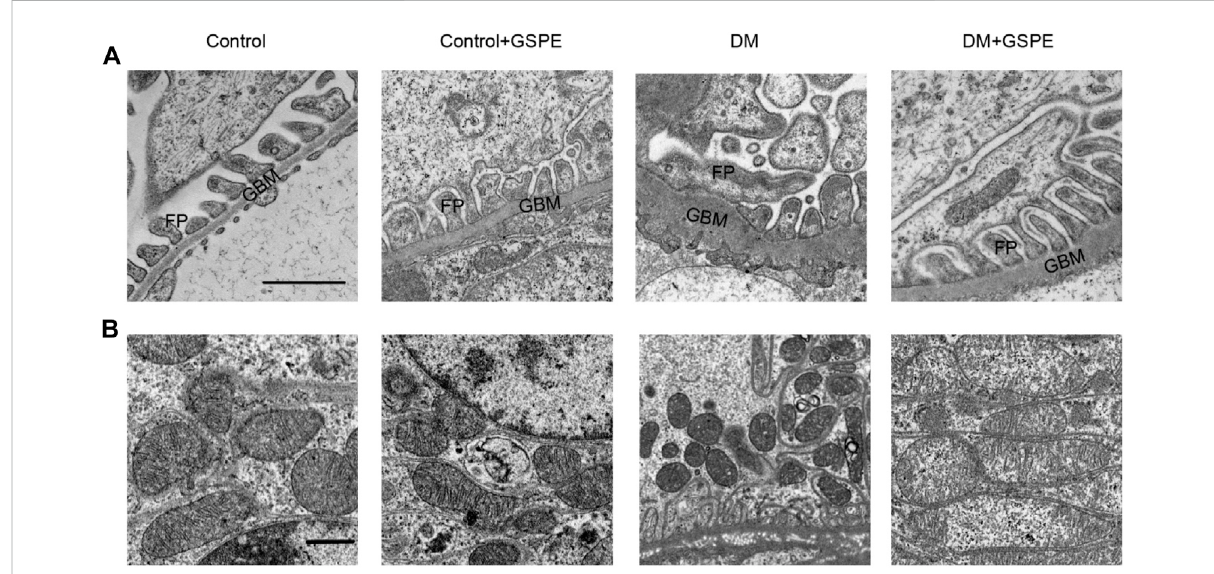
FIGURE 3 Electron microscopy delineated ultrastructural changes of podocyte and mitochondria in kidney biopsies in each group. (A) The images of podocytes were taken by electron microscopy (Scale bars, 1 μ m Original magni fi cation, ×10000). (B) The images of mitochondria were taken